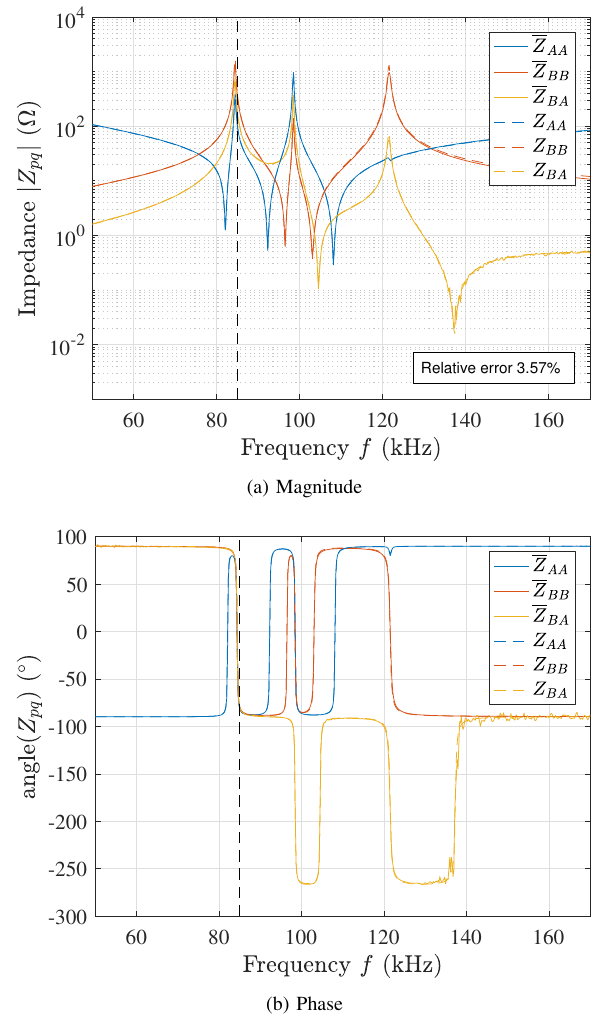
Fig. 6. Magnitude and phase of impedance matrix entries as a function of frequency: 1) solid curves – measurements Z pq ( f ν ) ; and 2) dashed curves – model Z pq ( f ν , p ∗ ) for the optimized parameter vector p ∗